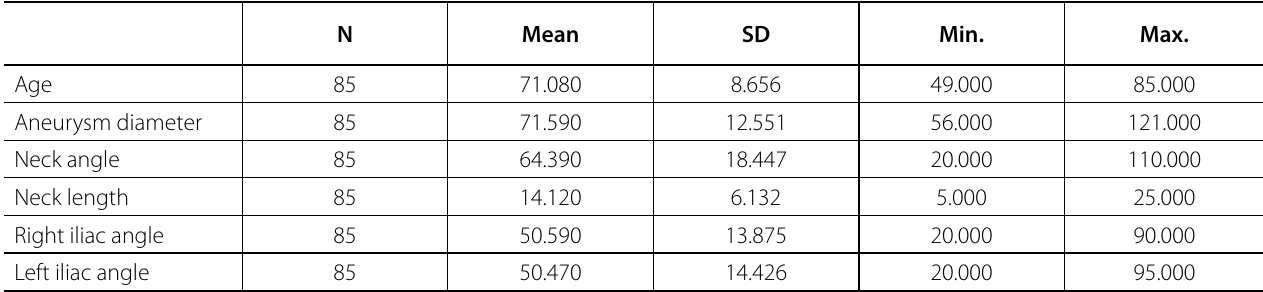
Table 2 . Patients’